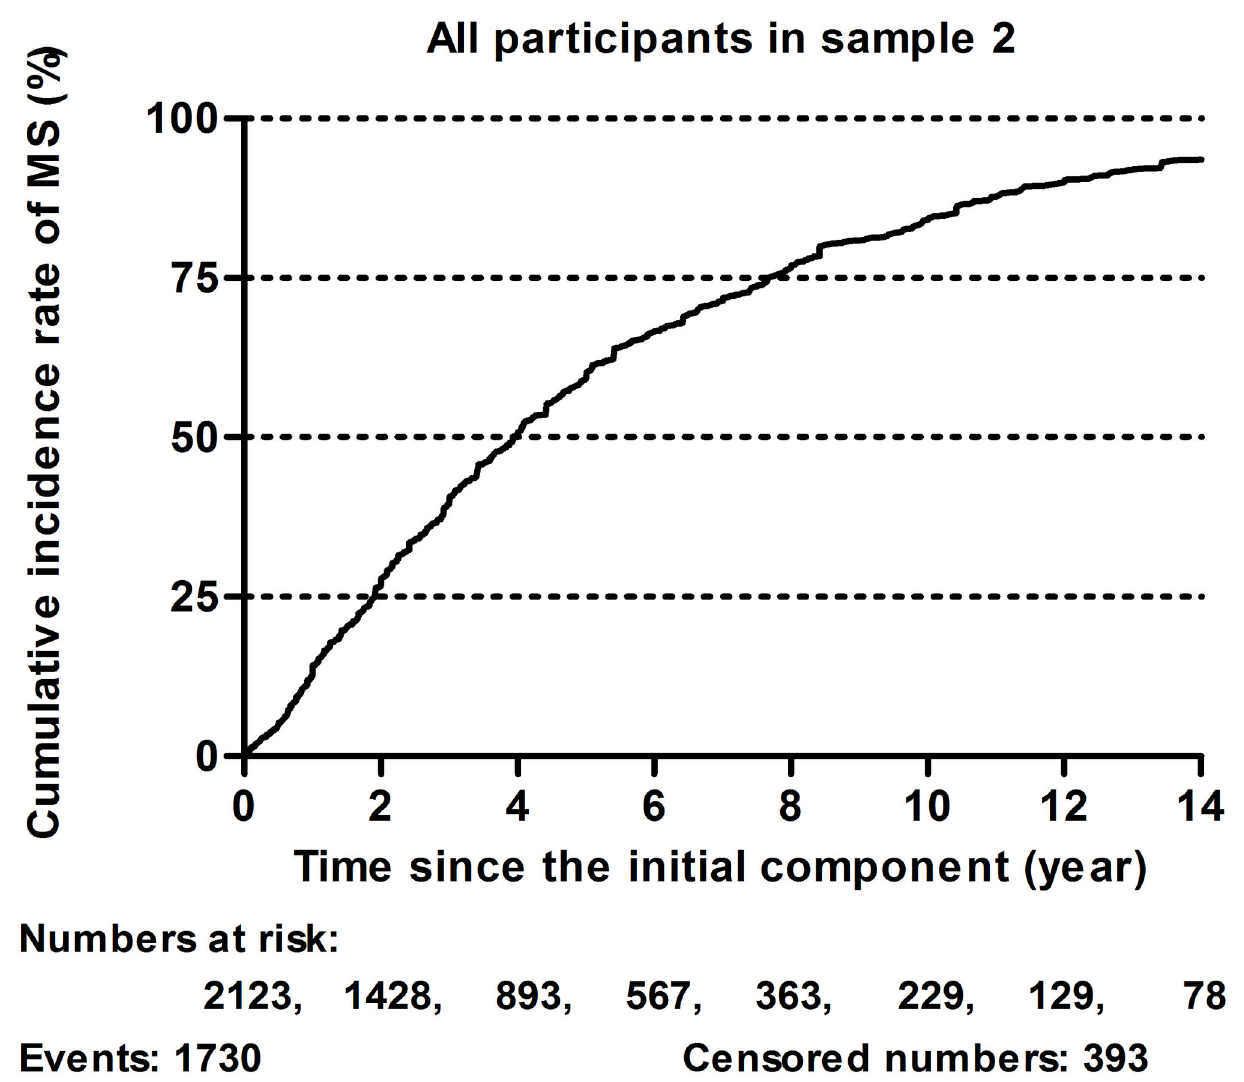
Figure 3. Kaplan-Meier curves of the cumulative incidence rates of metabolic syndrome for all participants in sample 2. Abbreviations: MS: metabolic